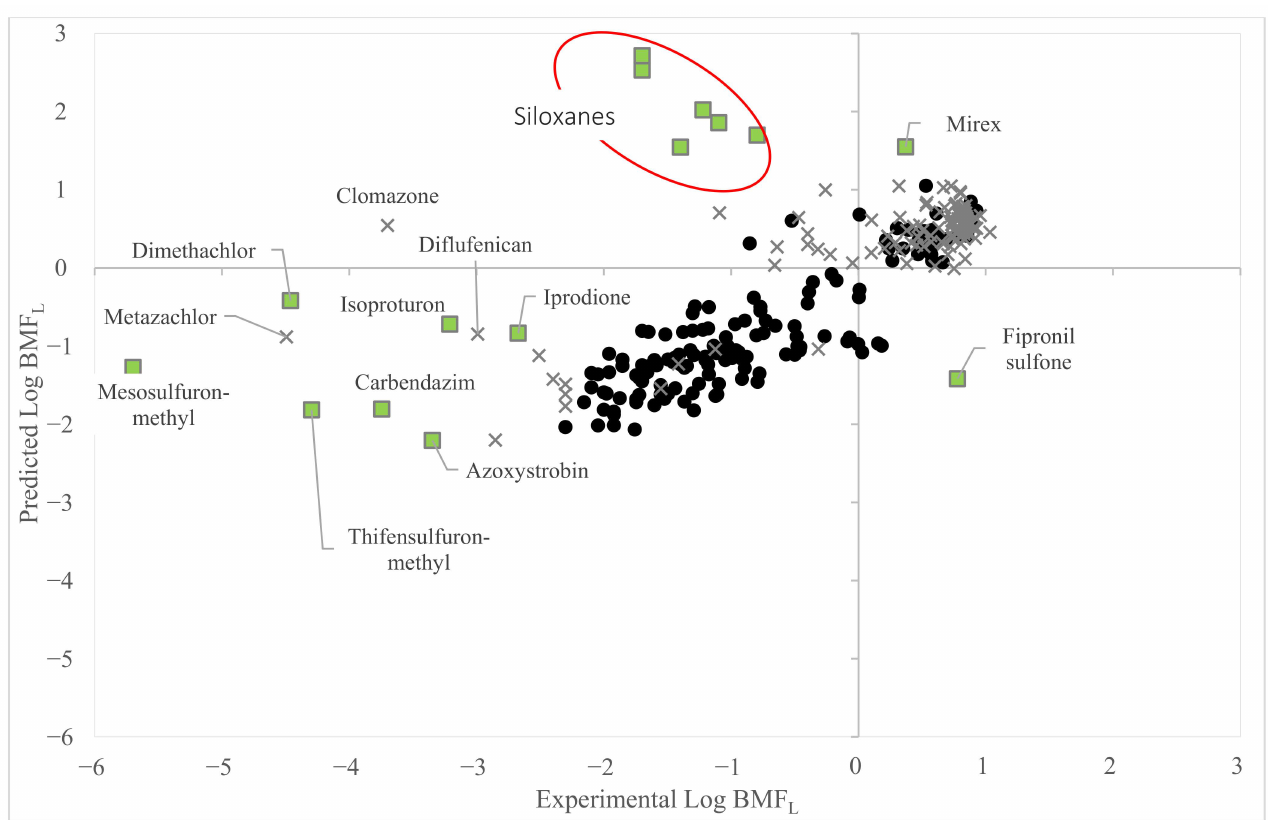
Figure 3. The figure shows the plot of the experimental (x-axis) vs. the predicted values (y-axis) of Equation (2), which are represented by black dots. Equation (2) is applied to predict remaining low-quality data. Data corresponding to low quality are here plotted with a grey “X” (data included in the AD) or squares (data excluded from the